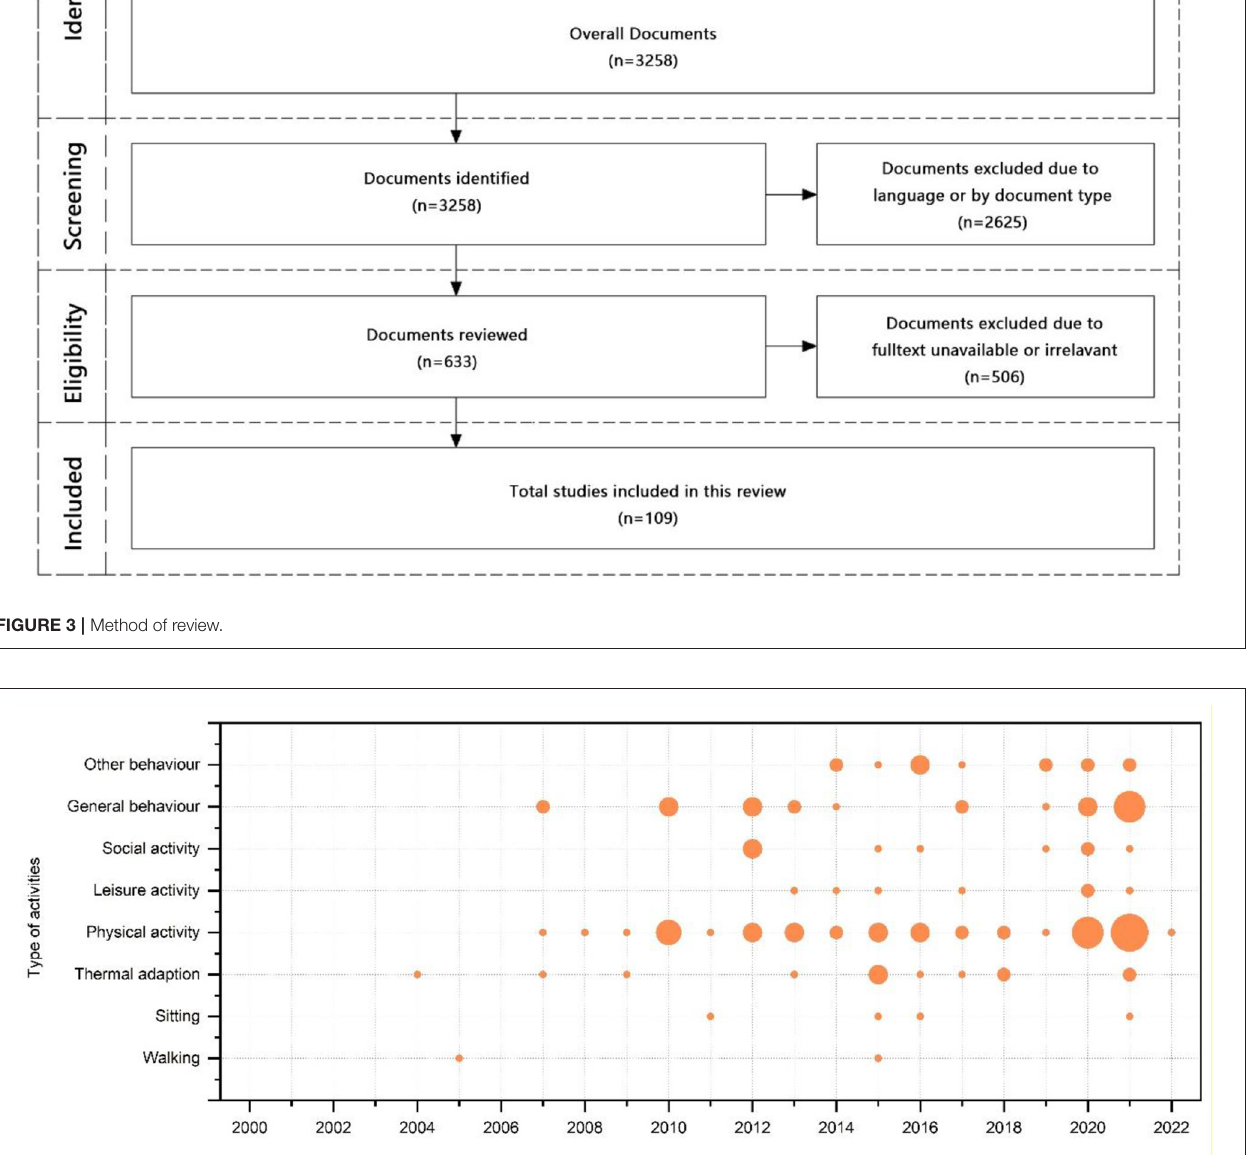
(2) Screening: Using keywords (outdoor OR public OR ‘open space’) AND (behavior OR behavior OR activity OR activities), 3,258 papers related to this review topic were